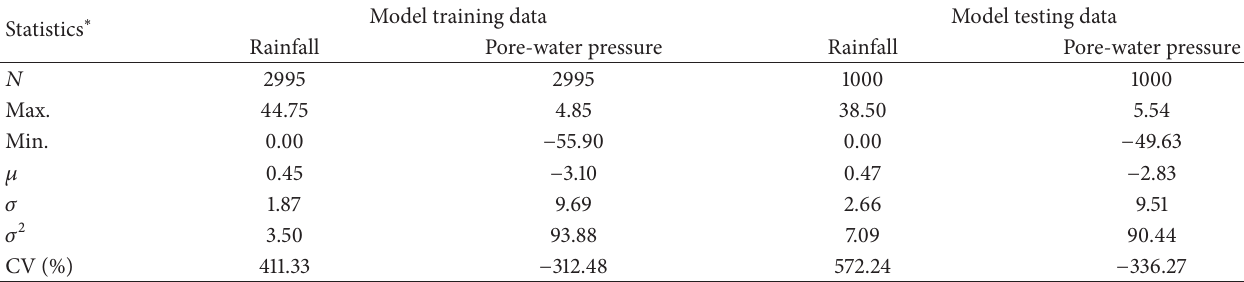
Table 1: Normal statistics of data used for training and validating the ANN model (soil depth = 0.5